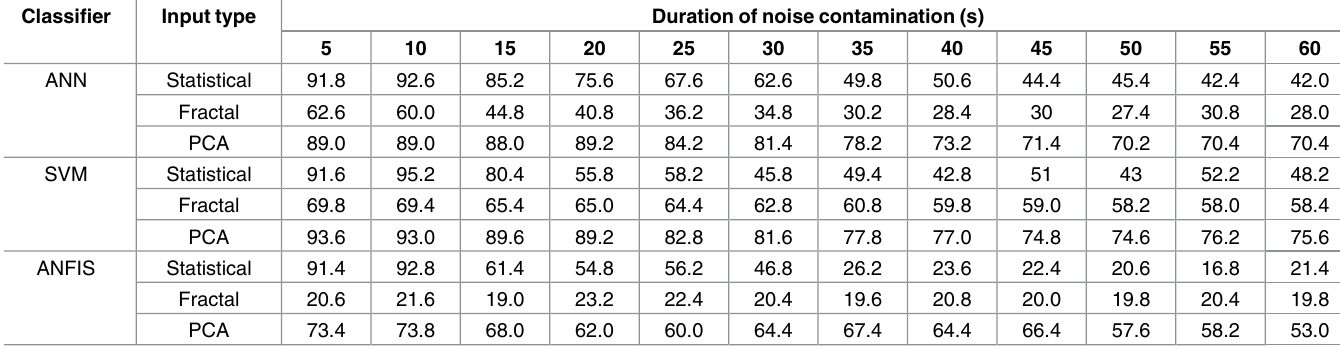
Table 6. Classification accuracyresults using PD data added with noise.